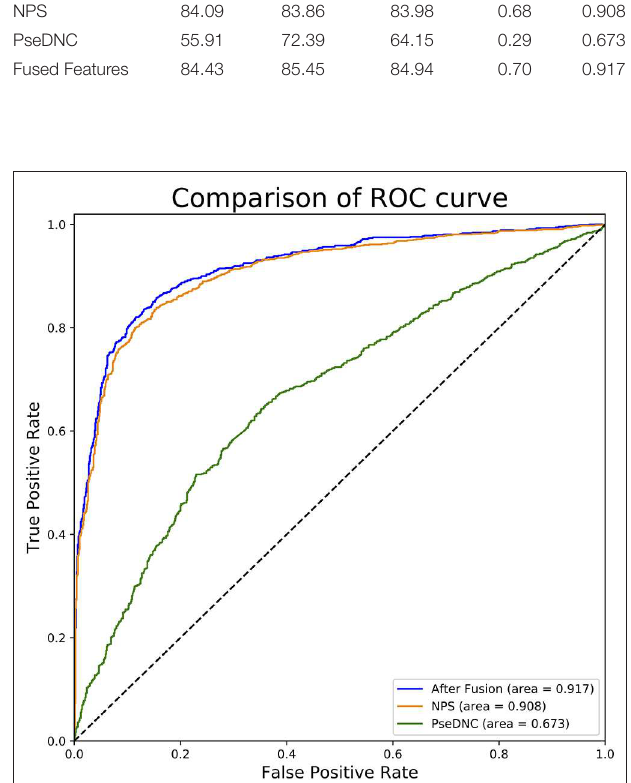
FIGURE 2 | ROC curves of single and fused features. This figure shows the ROC curve results of different features. The green curve characterizes ROC result of PseDNC and the orange one for NPS. The ROC curve of fused features is represented by blue.